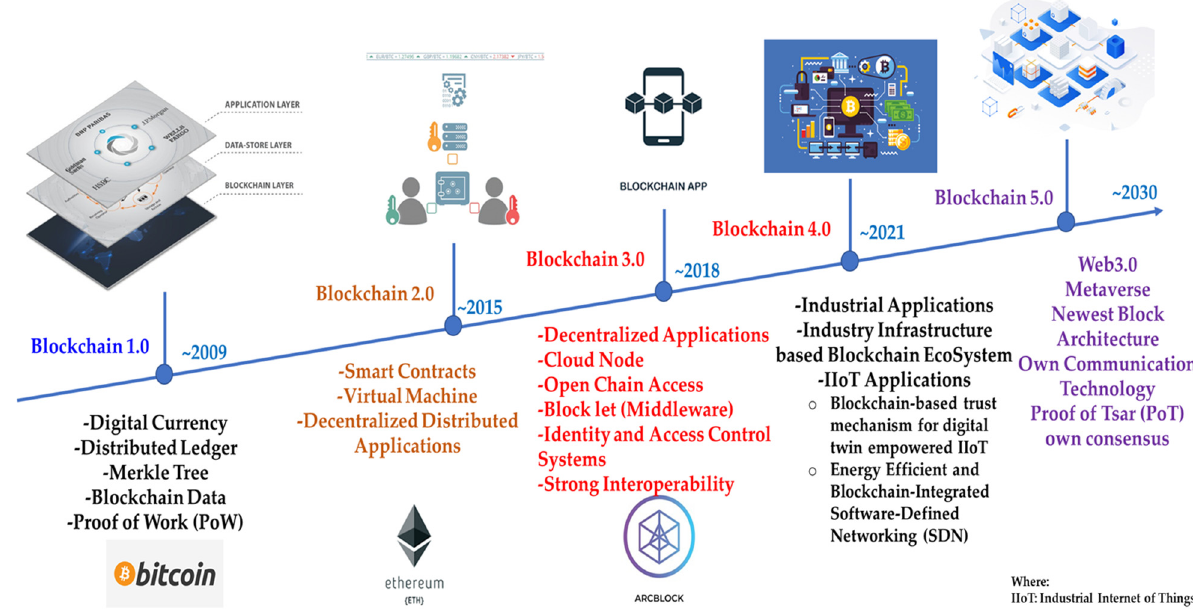
Figure 4. Evolution from Blockchain 1.0 up to Blockchain 5.0 .